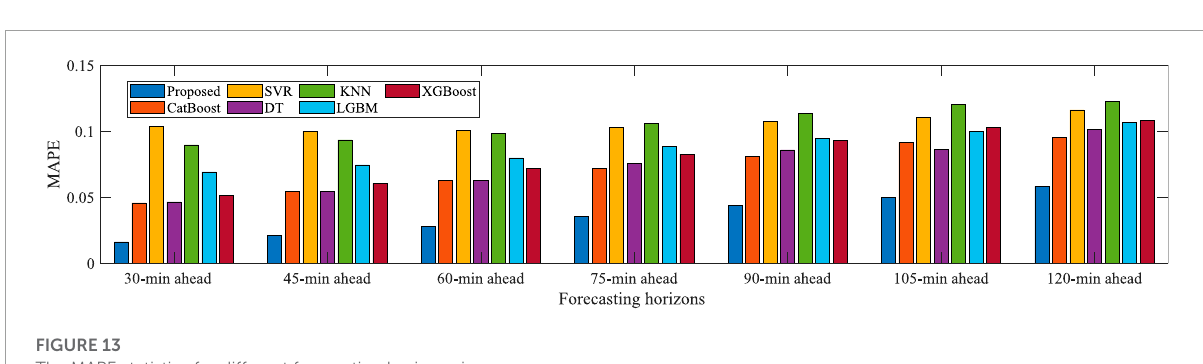
FIGURE 13 The MAPE statistics for different forecasting horizons in